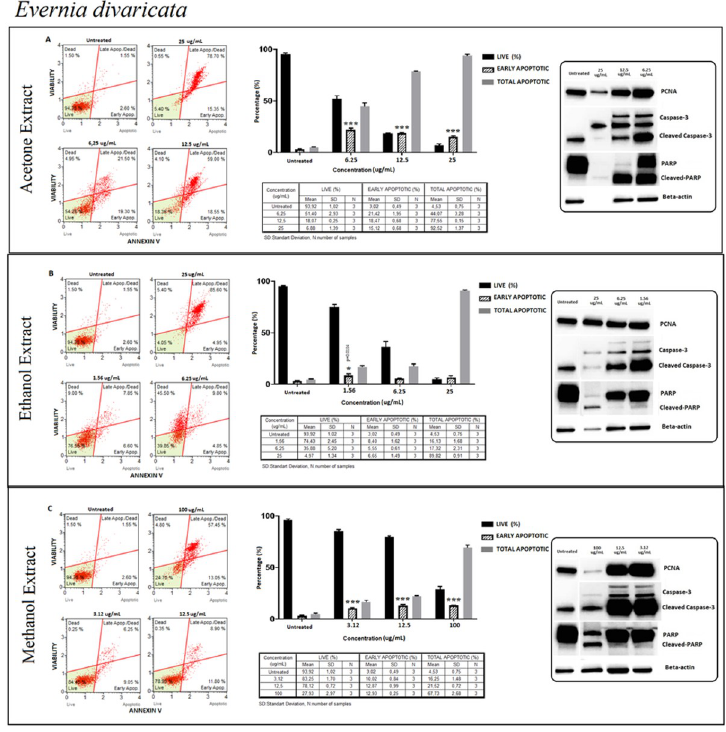
Fig 6. Evernia divaricata (ED); Annexin V/7’AAD staining flow cytometry results (scatterplots), statistical analysis (bar graphs), ± SD changes between experiments (tables) and protein levels of PCNA, caspase-3 and PARP by western blot (right panel) on PC-3 cells with three different extraction of acetone (results compiled in A), ethanol (results compiled in B) and methanol (results compiled in C) respectively. Annexin V/7’AAD staining by flow cytometry of ED on PC-3 cells was shown to induce apoptotic cell death by mainly early apoptosis. The gating was adjusted according to the untreated sample and the representative scatterplots were presented as the percentage of cells that were viable (Ann-V − and 7-AAD − ), early apoptotic (Ann-V + and 7-AAD − ), late apoptotic (Ann-V + and 7-AAD − ), and dead (Ann- V − and 7-AAD + ). Scatterplots are shown for untreated, 25 μ g/mL, 12.5 μ g/mL and 6.25 μ g/mL after 24 hours treatment with acetone extract (A) and for ethanol extract treatment; groups are untreated, 25 μ g/mL, 6.25 μ g/mL and 1.56 μ g/ mL after 48 hours treatment (B) and for methanol extract treatment; groups are untreated, 100 μ g/mL, 12.5 μ g/mL and 3.12 μ g/mL after 72 hours treatment (C) respectively. The 25 μ g/mL concentration is determined as toxic dose for acetone and ethanol extracts groups and the 100 μ g/mL concentration is determined as toxic dose for methanol extract group. Results were analyzed and presented as the percentage of three independent experiments of live, early apoptotic and total apoptotic after treatment (bar graphs). Flow cytometry was shown to induce apoptotic cell death by mainly early apoptosis (except ethanol extract). The significance of only early apoptosis for each concentration indicated with an asterisk and the p value was only presented when the significance level of early apoptosis rate between 0.05 and 0.01. ± SD changes between apoptosis assays were indicated as the mean value and SD changes per concentration and per group of live-early apoptotic-total apoptotic separately (table). Western blot results of proliferating cell marker PCNA and apoptosis-related proteins (right panel) were presented. Dose-dependent PCNA, cleavage of caspase-3 and, PARP respectively. Particularly, acetone extract group showed significant increase with 24 hours of treatment for apoptosis by flow cytometry and western blot respectively, even with higher proliferation rate of PCNA. Ethanol and methanol extract groups showed increased apoptosis rate (only by flow cytometry) with specified concentrations however even marked increase for cleaved caspase-3 rate, cleaved-PARP did not showed significant rate, as presented in the western blot (right panel) when compared with untreated group. � p < 0 . 05 , �� p < 0 . 001 , ��� p < 0 . 0001 (all p -values were obtained by two-way ANOVA following Dunnet’s multiple comparison